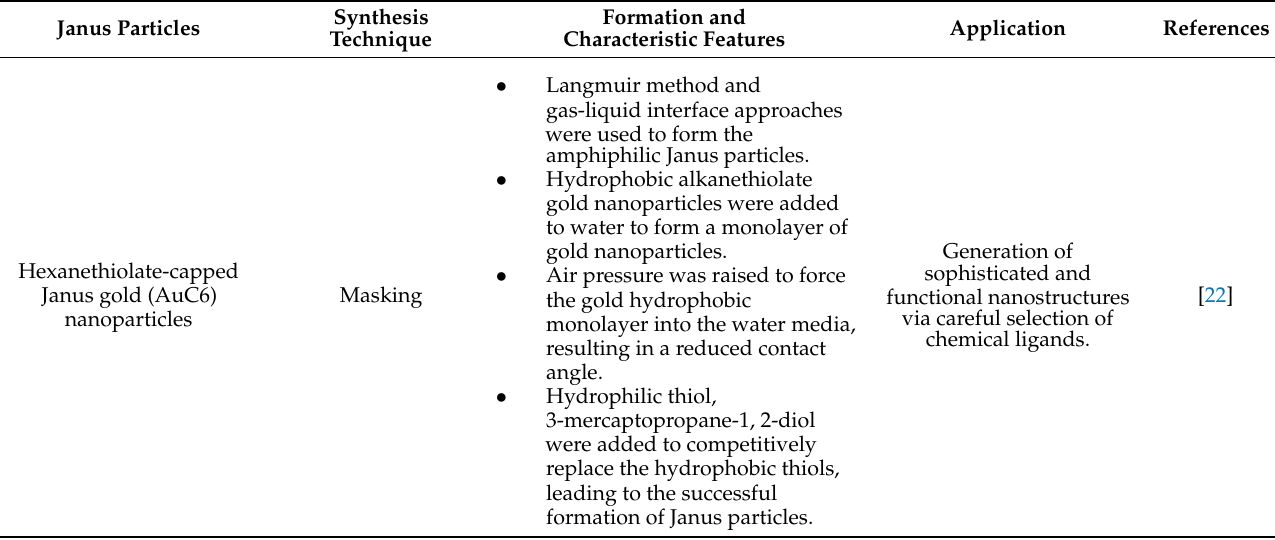
Figure 2. Interparticle interaction of stable Janus particles in fluid interfaces. ( a ) Surface group dissociation leading to dipole-dipole-based repulsive interactions; ( b ) Oil phase-based contact of particle surface for water entrapment leading to long-range repulsive interactions; ( c ) Generate attractive capillary interactions via gravitational forces deformed interface and ( d ) Surface roughness improved by interface undulations to enhance the stability of Janus particles via capillary interaction. Reproduced with permission from Correia et al. (2021), © MDPI, 2021 [21] (Open access). Table 1. Generation of Janus particles via distinct fabrication techniques for various